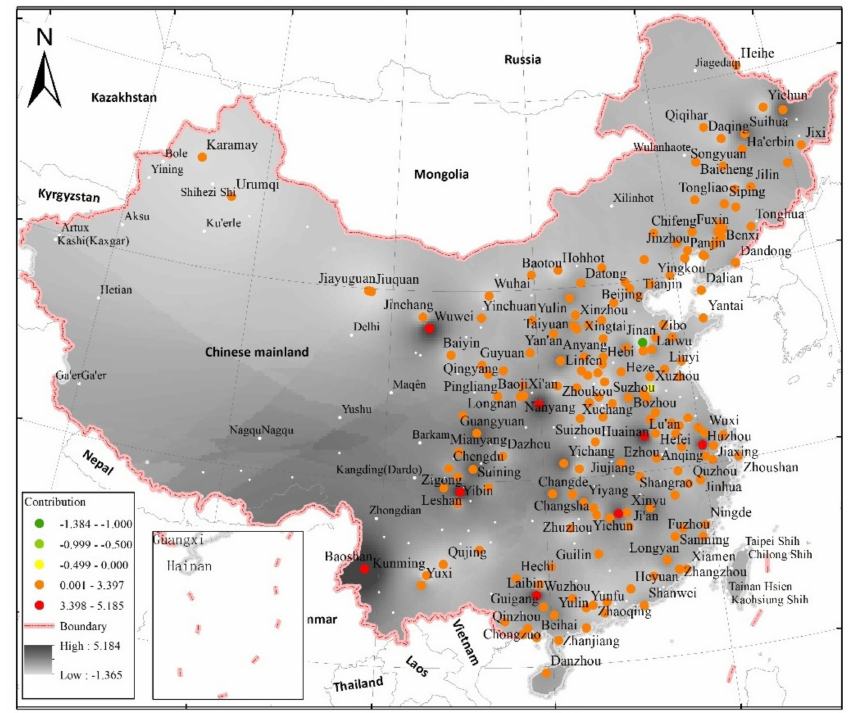
Figure A4. Contribution from the indicator GRPMD (gross regional product of municipal district/s (CNY/capita)) to land-use intensity revealed in the city-based assessment.